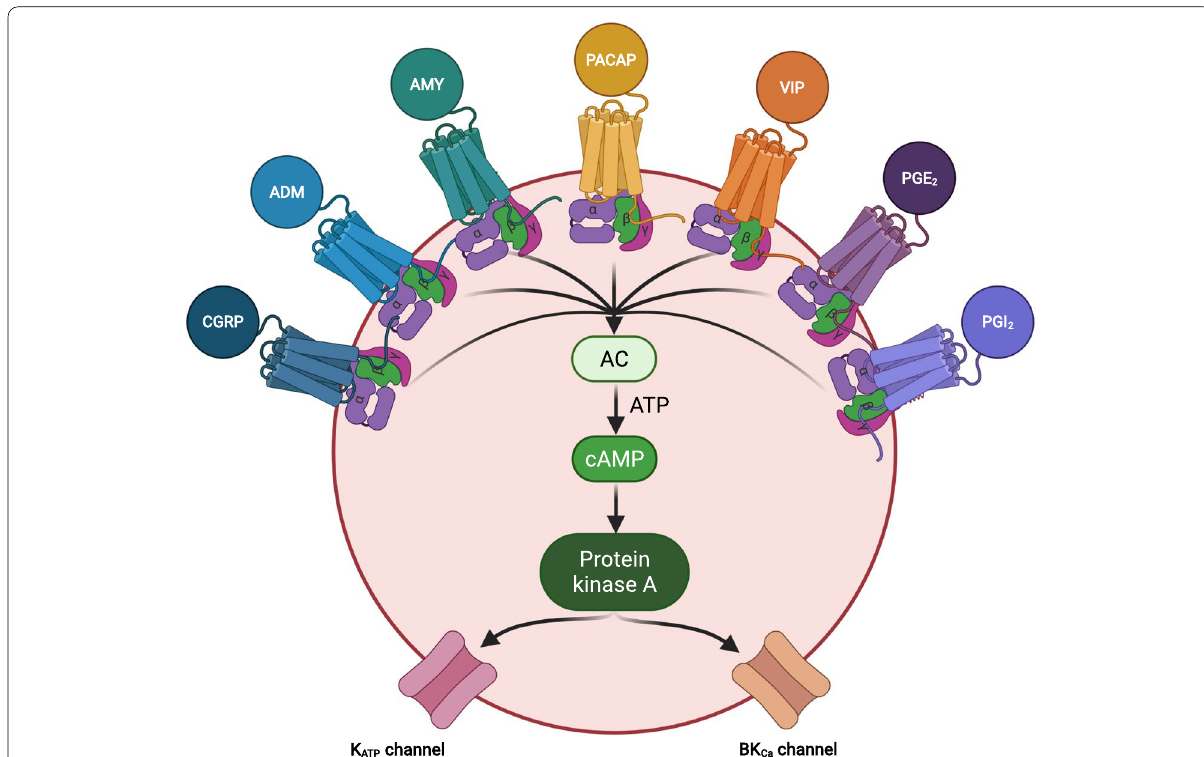
Fig. 1 cAMP-dependent pathways in migraine pathophysiology. The cell is a vascular smooth muscle cell within the walls of intracranial arteries. Experimental studies have shown that binding of calcitonin gene-related peptide (CGRP), adrenomedullin (ADM), amylin (AMY), Pituitary adenylate cyclase-activating polypeptide (PACAP), vasoactive intestinal polypeptide (VIP), prostaglandin E 2 (PGE 2 ), and prostaglandin I 2 (PGI 2 ) to their G protein-coupled receptors increases the intracellular concentration of cyclic adenosine monophosphate (cAMP) and thereby activates the cAMP-dependent pathway. This will then activate protein kinase A which, in turn, results in outflow of potassium via opening of adenosine triphosphate-sensitive potassium (K ATP ) channels and large conductance calcium-activated potassium (BK Ca ) channels. The end result is hyperpolarization of the vascular smooth muscle and accompanying vasodilation which is hypothesized to provide the necessary chemical and mechanical stimuli needed to activate and sensitize perivascular nociceptors [2]. AC, adenylate cyclase; ADM, adrenomedullin; AMY, amylin; ATP, adenosine triphosphate; BK CA , large conductance calcium-activated potassium channels; cAMP, cyclic adenosine monophosphate; CGRP, calcitonin-gene related peptide; K ATP -channels, adenosine triphosphate-sensitive potassium channels; PACAP, pituitary adenylate cyclase activating polypeptide; PGE 2 , prostaglandin E 2 ; PGI 2 , prostaglandin I 2 ; Protein kinase A, cAMP-dependent protein kinase; VIP, vasoactive intestinal